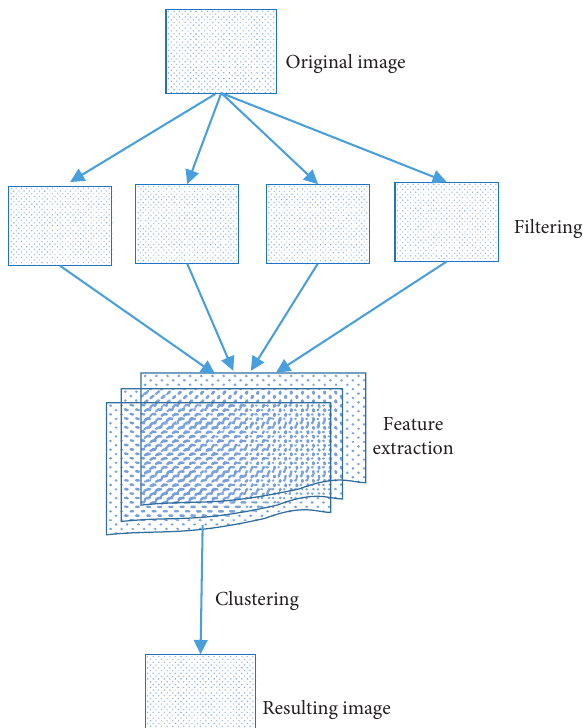
Figure 6: Texture features filtered from original image and clus- tered to result in segmented